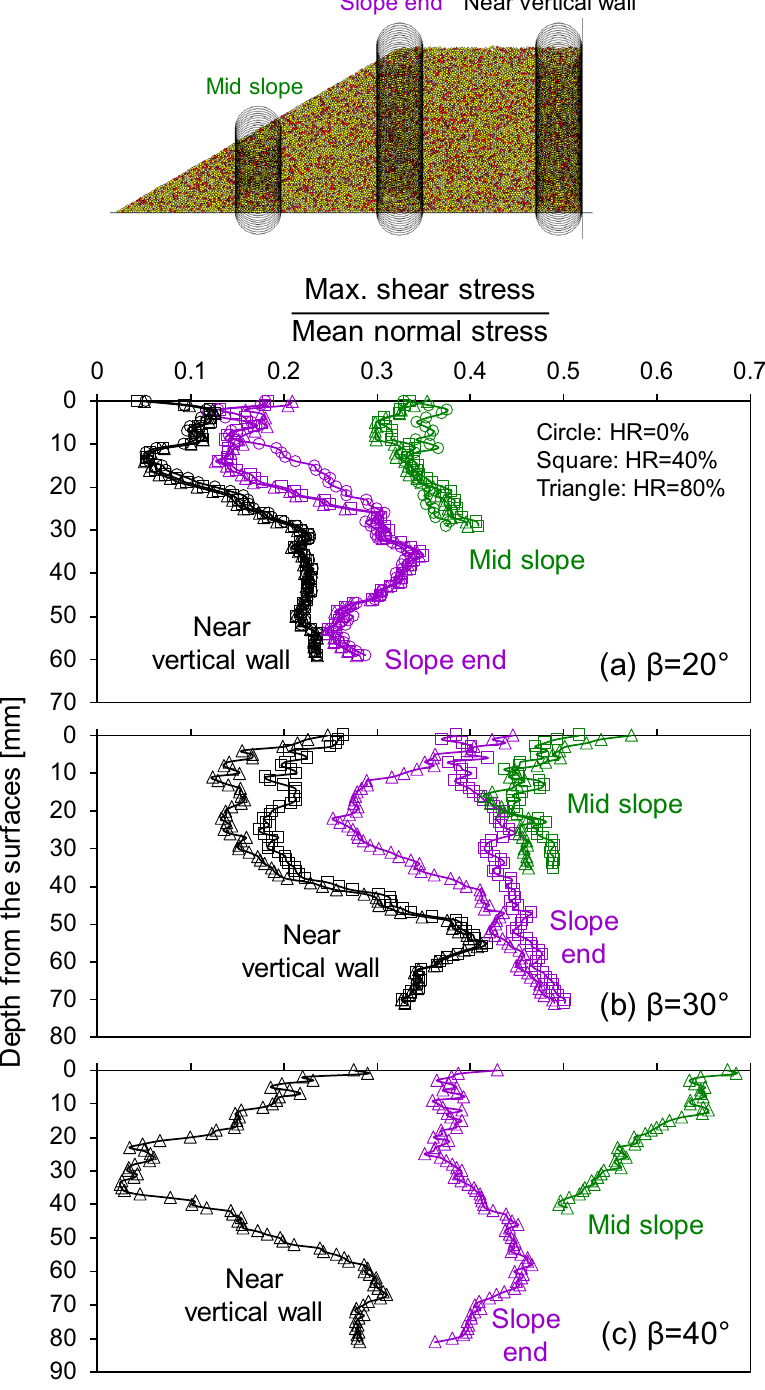
Figure 5. The distribution of maximum shear stress divided by the mean normal stress in the mid slopes, slope ends and near the vertical walls. Note each data point is the average value within the measurement circles located as